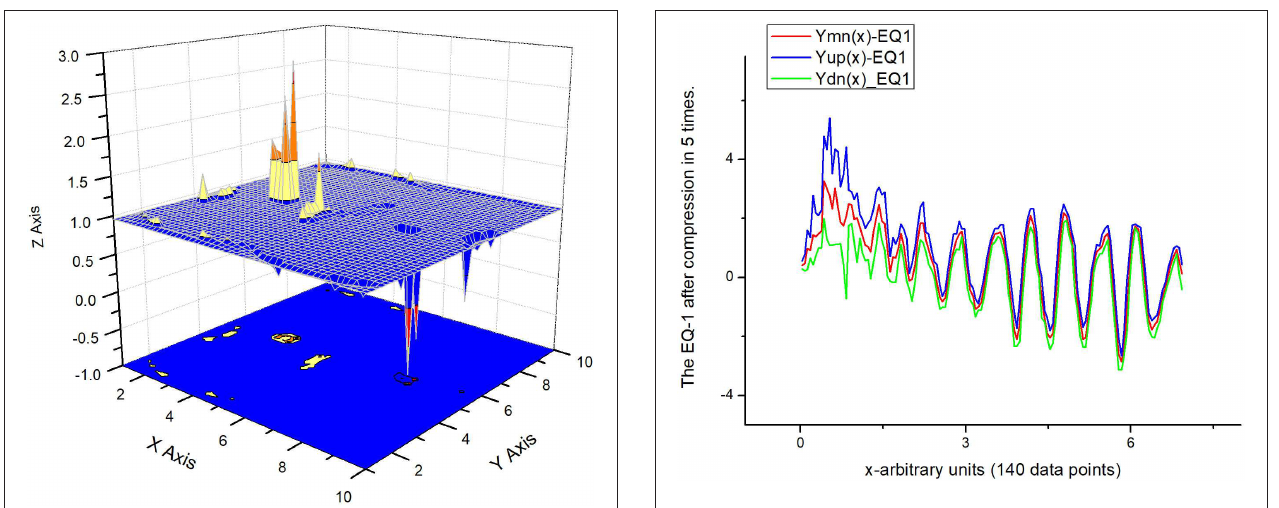
FIGURE 9 | The recorded signal corresponding to the EQ-1. After compression by a factor of 5 ( b = 5) the reduced signal contains 140 data points only.